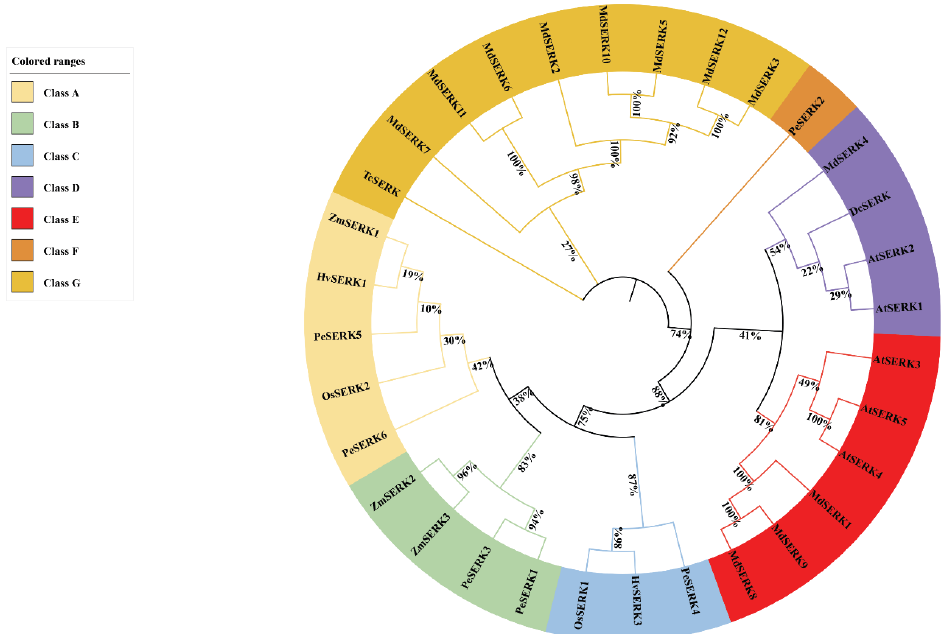
Figure 2. Maximum likelihood phylogenetic tree of SERK proteins. The tree was constructed with protein sequences encoded by the longest transcript of each SERK in moso bamboo, and SERK protein sequences in Arabidopsis thaliana (At), Malus domestica (Md), Oryza sativa (Os), Hordeum vulgare (Hv), Zea mays (Zm), Daucus carota (Dc) and Theobroma cacao (Tc) with bootstrap values of replicates. Different groups of SERK proteins are distinguished by different colors.